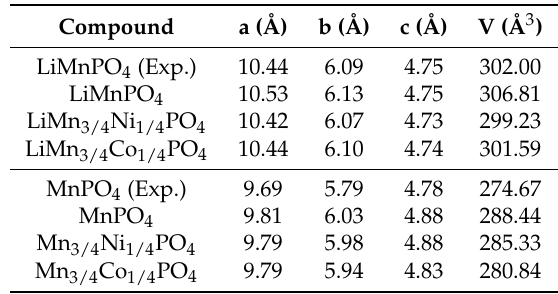
Table 1. Optimized lattice parameters for LiMnPO 4 , MnPO 4 , and for the doped materials. For the starting materials, experimental values (Exp.) [10] are reported for comparison. The introduction of Ni and Co in the structure results in a contraction of the cell.